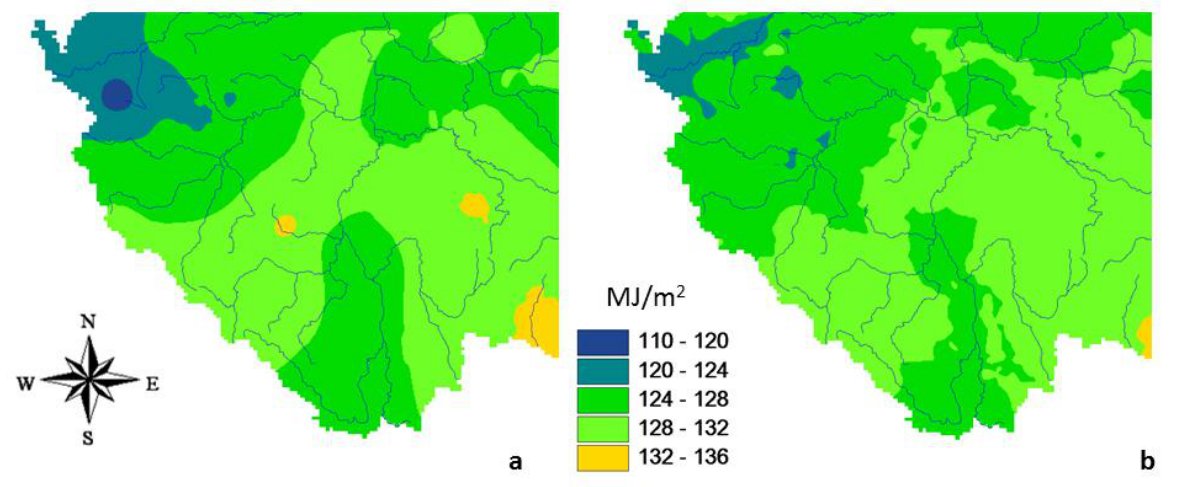
Figure 6. Example of SIS map used for TRY computation (southwestern part of Bohemia) for May (( a ) based on station data only, ( b ) combination of both station and CMSAF